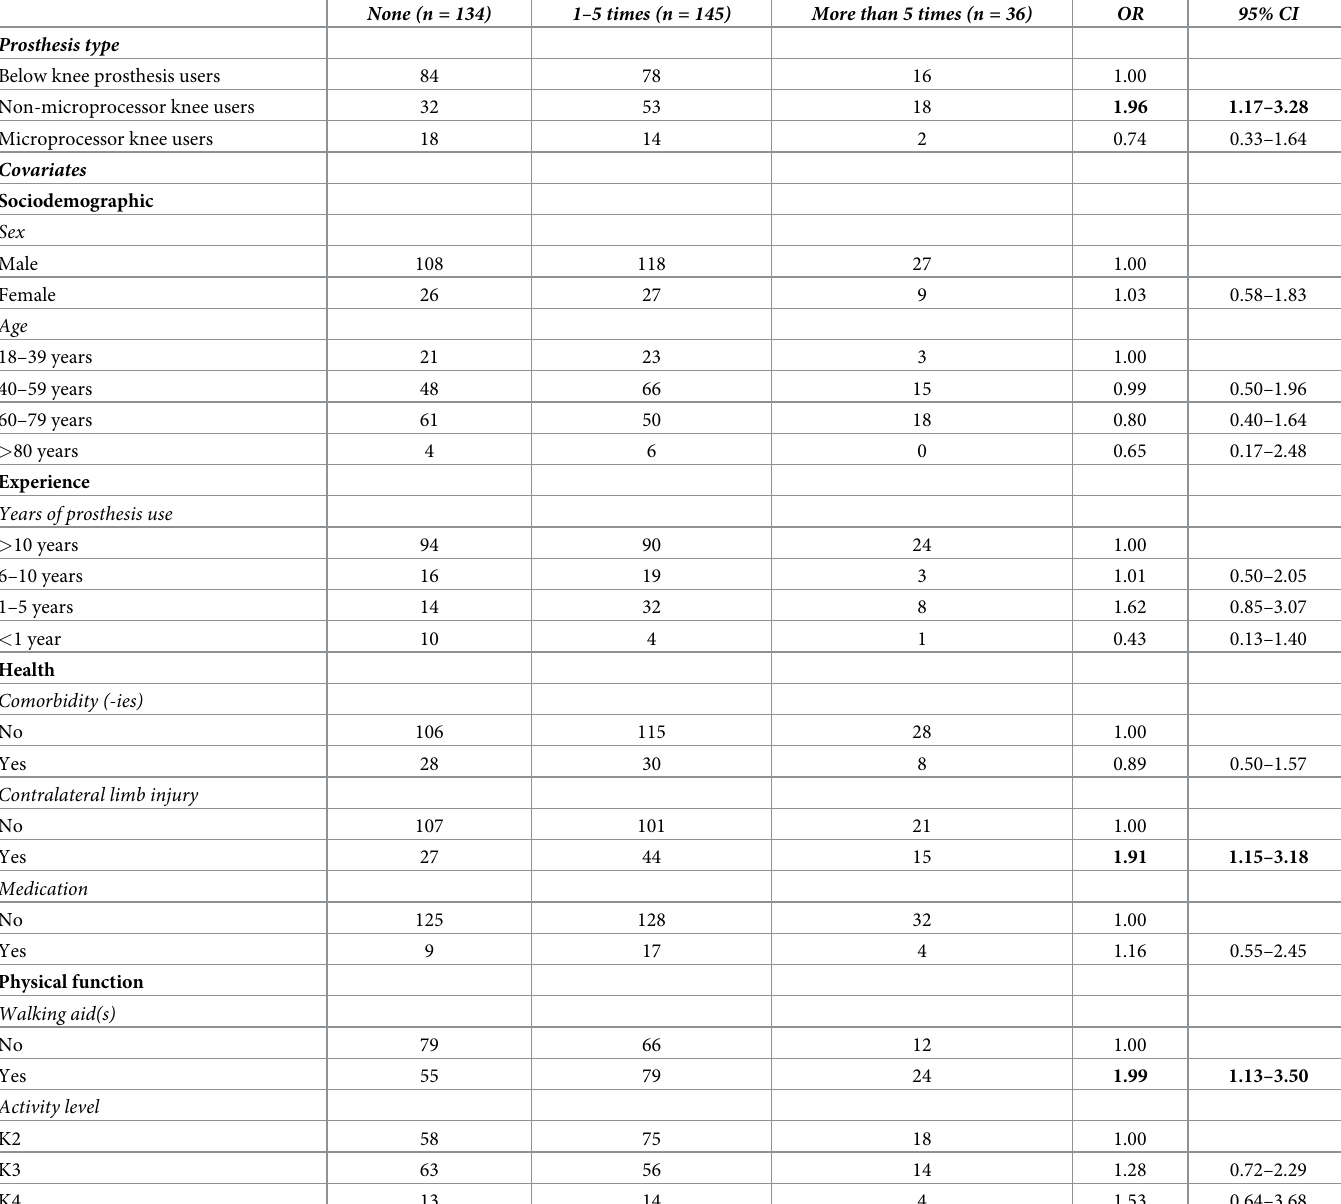
Table 1. The frequency of trips/stumbles by prosthesis type and each of the covariates. Odds ratios (OR) and 95% Confidence Intervals (CI) are shown; bold text indi- cates statistically significant observations. None (n = 134) 1–5 times (n =